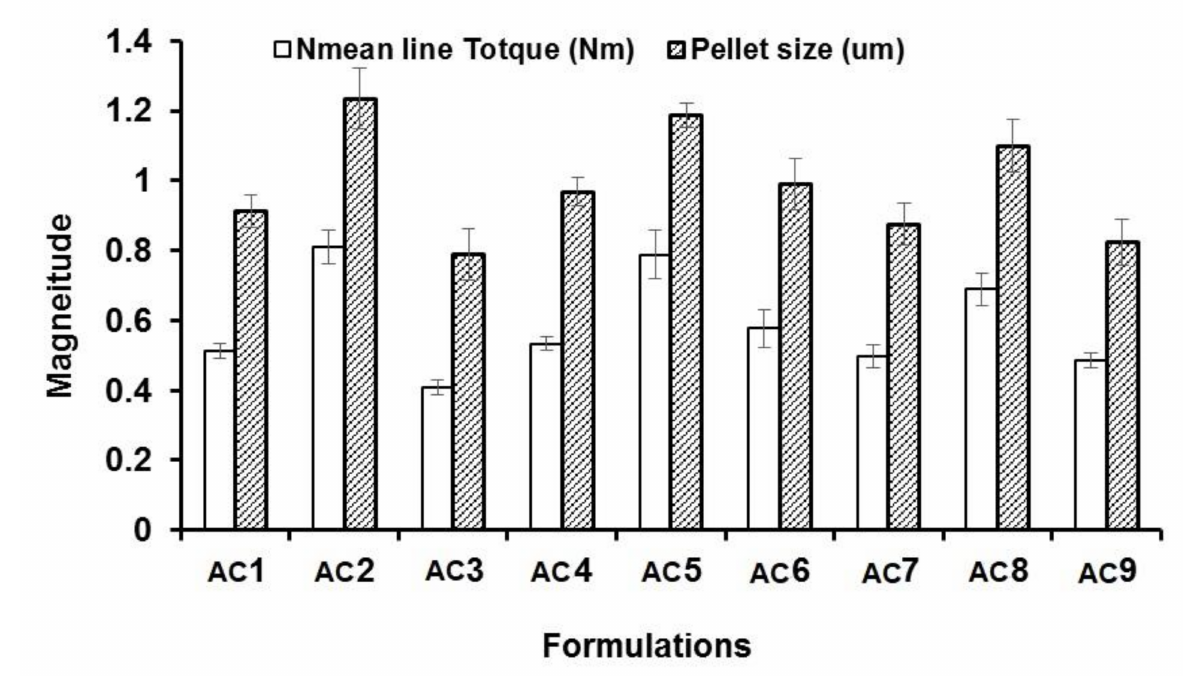
Figure 3. Mean line torque and pellet size of AC from different